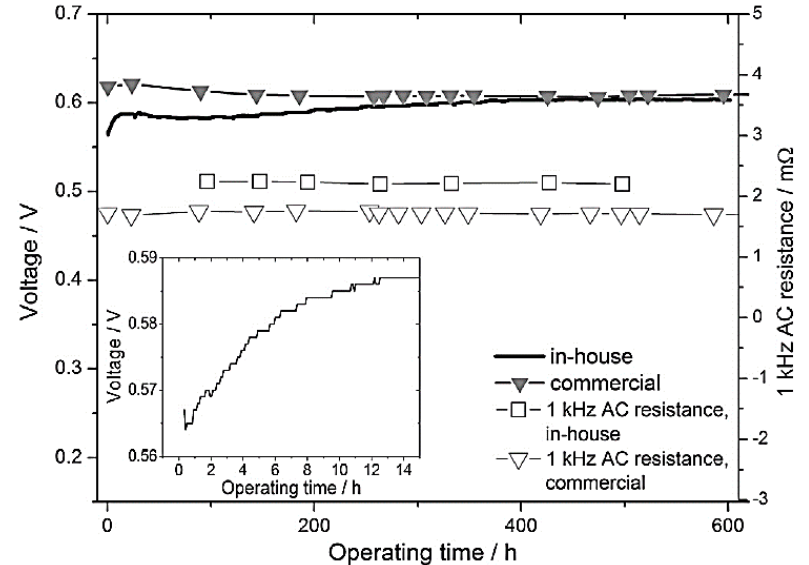
Figure 2. Comparison of cell voltages and the corresponding 1 kHz alternating current